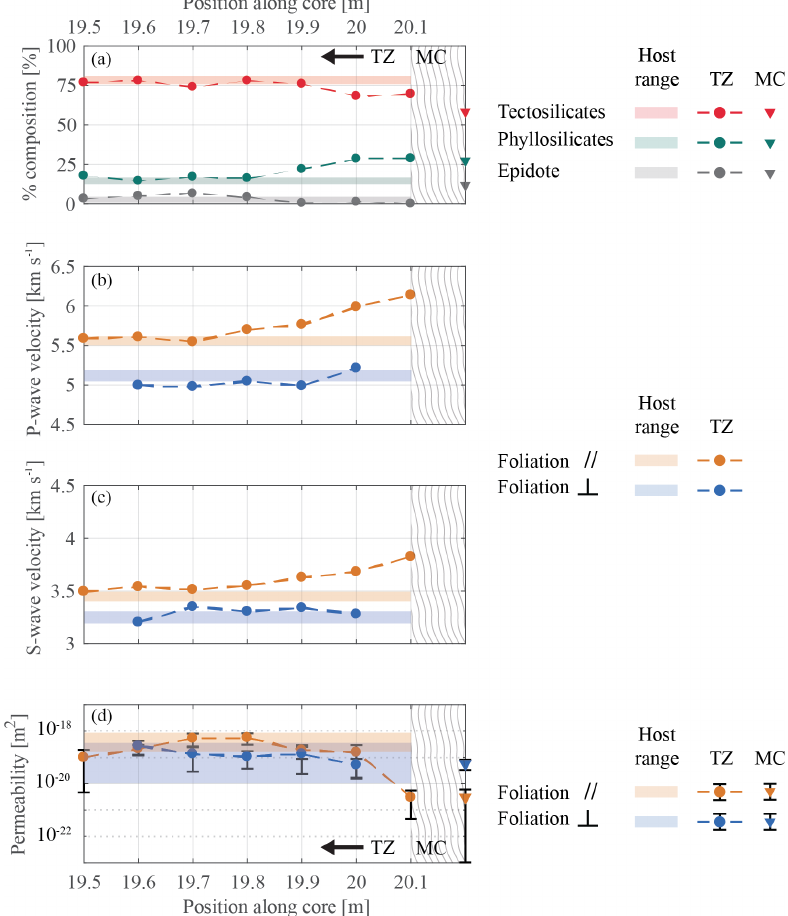
Figure 3. Sample composition, seismic velocity, and permeability across the transition zone into the mylonitic core. Depth corresponds to sample name in Table 2. (a) Tectosilicates – quartz, plagioclase, and K-feldspar (red); phyllosilicates – biotite and muscovite (green); and epidote (grey). (b, c) P- and S-wave velocity parallel to foliation (orange) and perpendicular to foliation (blue). Measured at 30MPa hydrostatic confining pressure. (d) Permeability parallel to foliation (orange) and perpendicular (blue). Permeability is reported as the median value measured for each sample, and the bars show the range of values in terms of minimum and maximum. Measured at 10MPa effective pressure. For all panels the shaded region depicts the range of values from the host granodiorite samples (S5 and S7), the circular markers show the values measured through the transition zone (TZ), and the triangular markers show the values measured in the mylonitic core (MC). Error bars are depicted where the error is larger than the marker